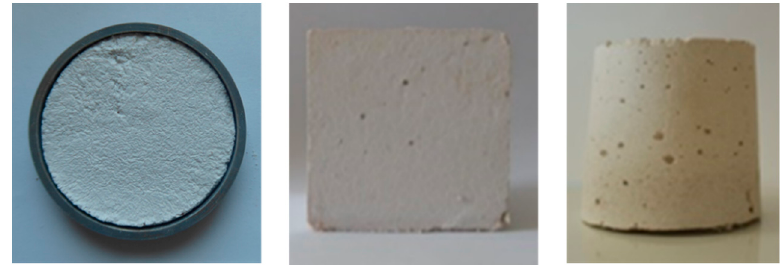
Figure 2. Type of specimens for the laboratory analyses—biscuit, cube, cylindrical specimen.